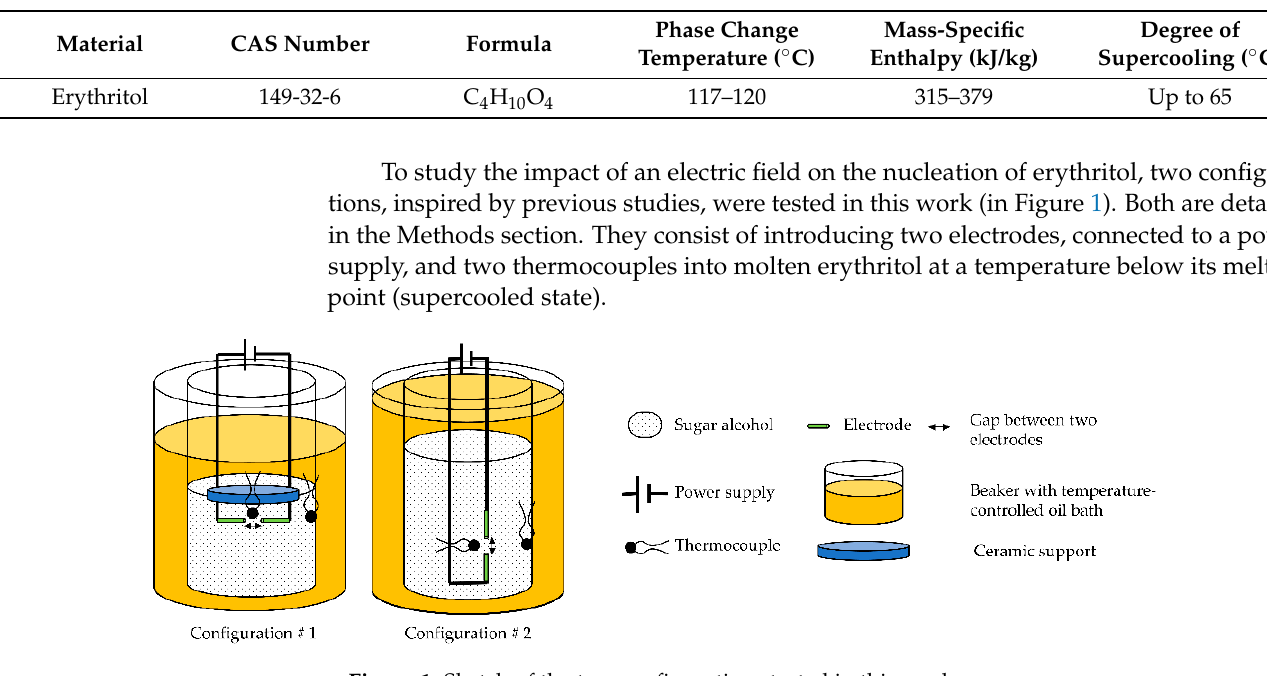
Figure 1. Sketch of the two configurations tested in this work. The different electrodes used in the two configurations are presented in Table 2. Table 2. Description of the electrodes used in the two configurations. Configuration